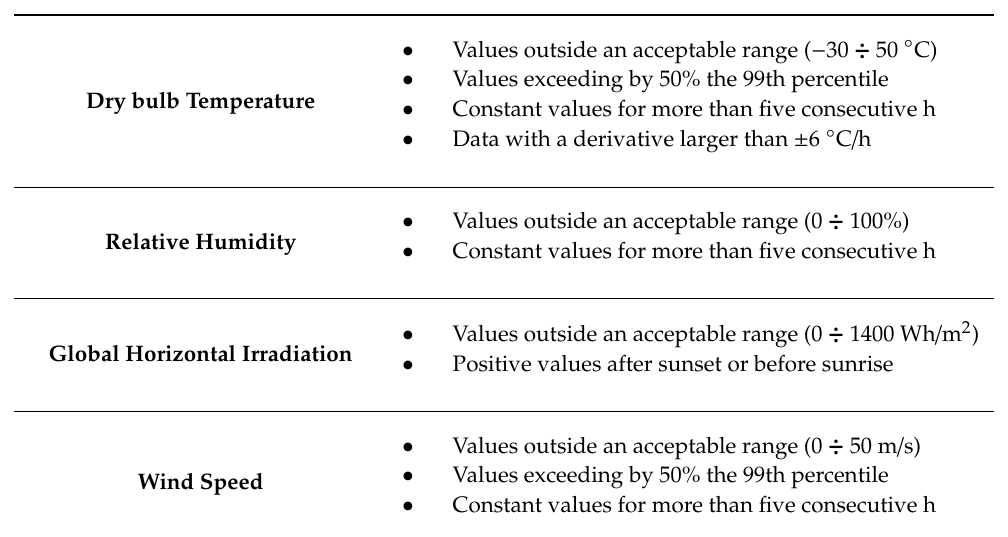
Table 4. Criteria leading to the identification of invalid measured data.